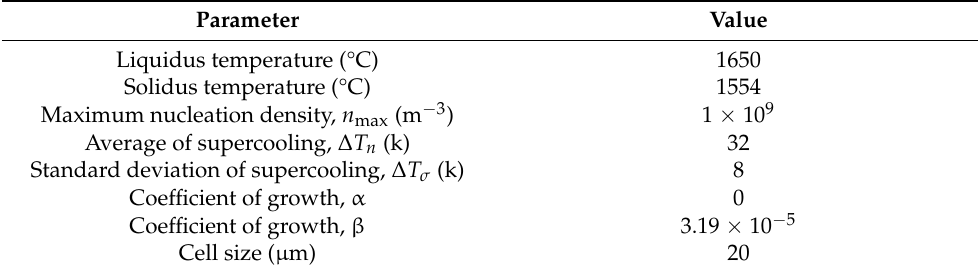
Table 4. The experiment and simulation comparison of the four-layer microstructures. Experiment CA Relative Error (%) Average length (mm) 1.97 2.01 2.03 Average width (mm) 0.85 0.81